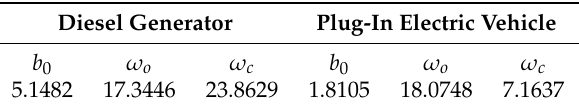
Table 3. Parameters of the centralized control strategy (CCS)-improved linear active disturbance rejection control (ILADRC) used for the simulation.